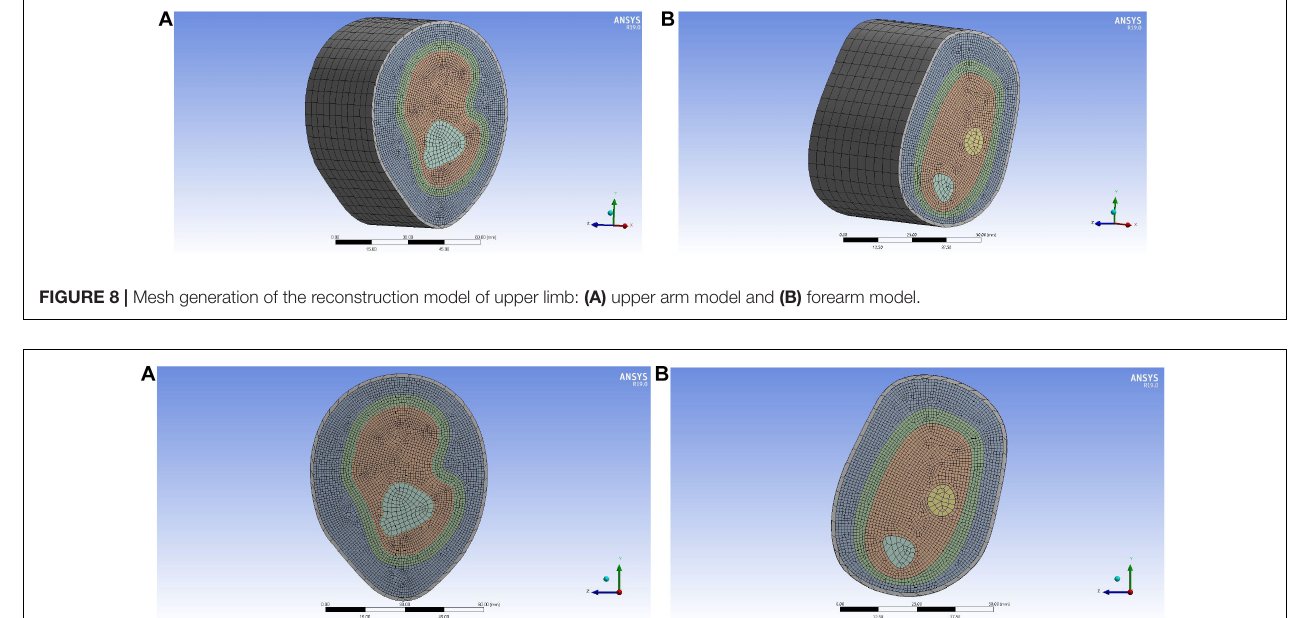
FIGURE 9 | Cross-section of the reconstruction model of upper limb meshing: (A) upper arm model and (B) forearm model.